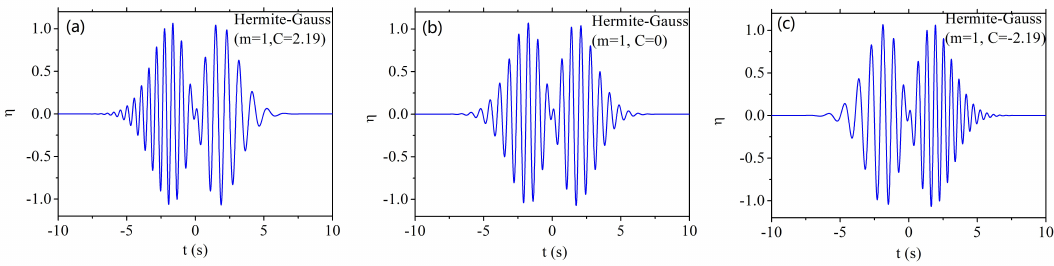
Figure 4. Envelopes (blue curves) of the Hermite-Gauss packet with different order A ( t ) = H m exp ( − ( t / t 0 ) 2 ) , where H m is Hermite polynomial. HG1 envelope function with carrier wave and chirp, given by η = H m exp ( − ( 1 + iC )( t / t 0 ) 2 ) exp ( − i ω 0 t ) , with, ( a ) C = 2.19 ( b ) C = 0, and ( c ) C = − 2.19 ; t 0 = 2.5 s; ω 0 = 9